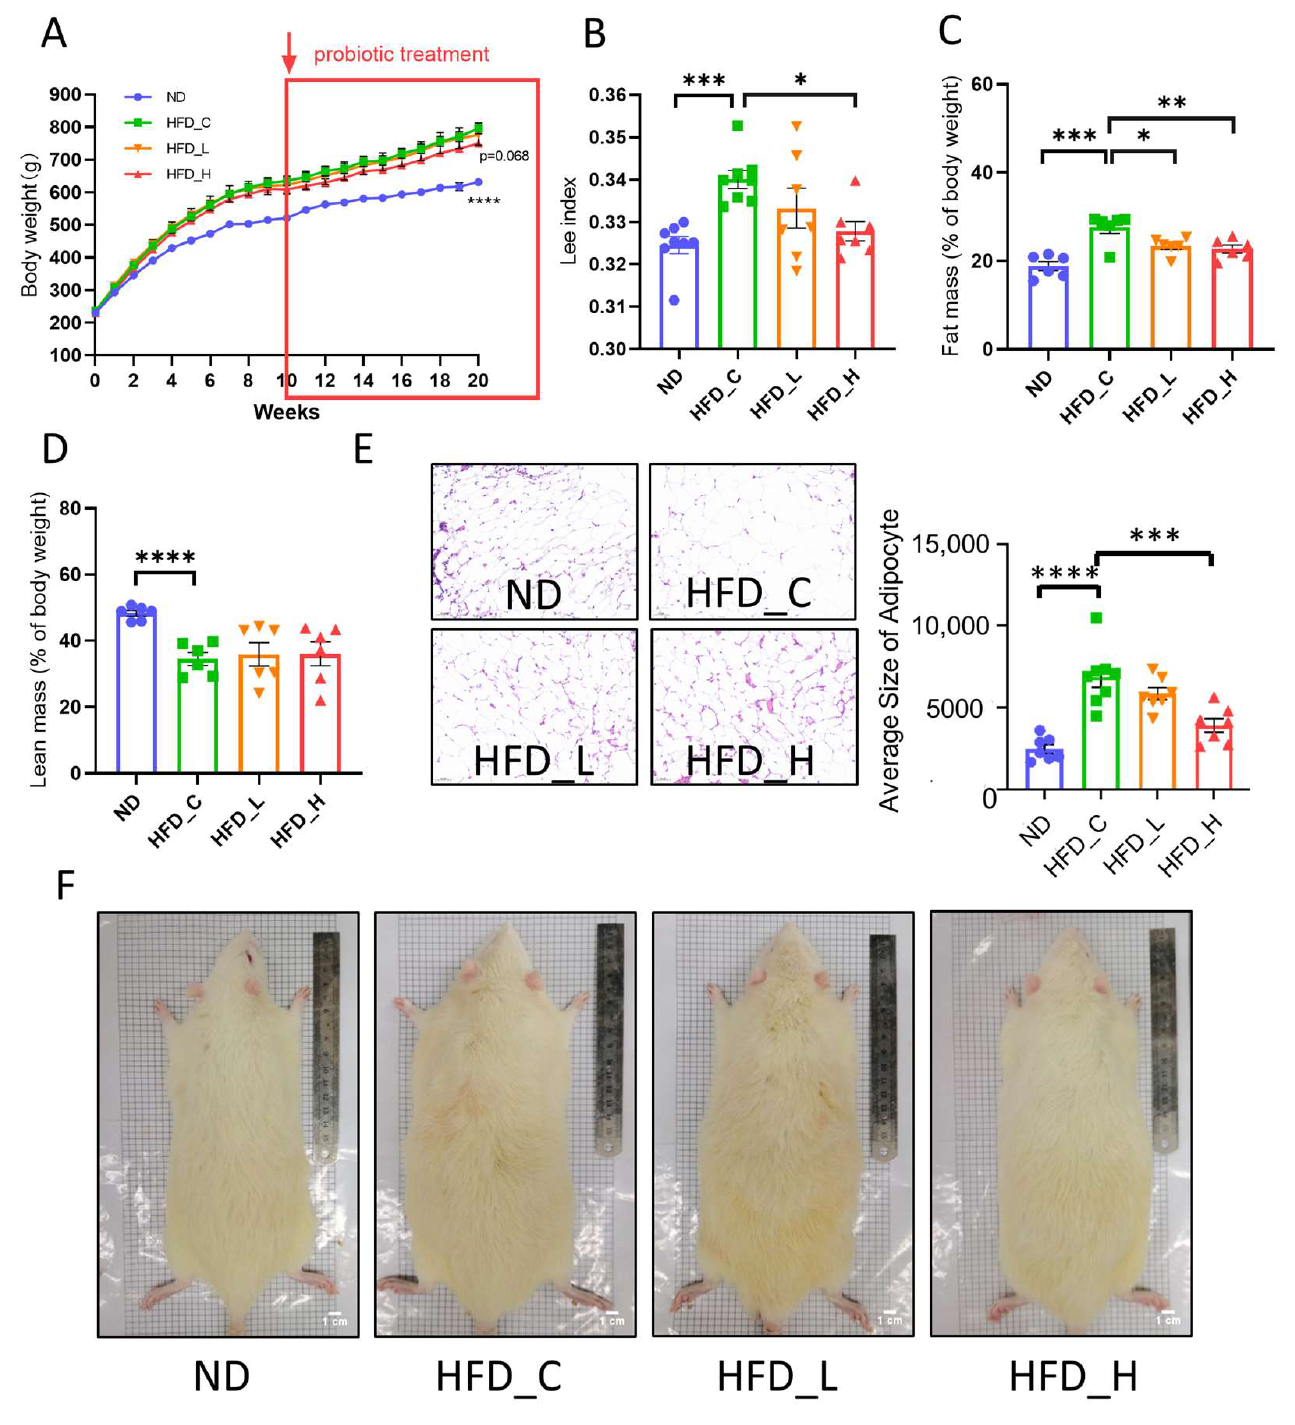
Figure 1. Effects of symbiotic supplementation on body weight and body fat in rats. Comparative measurements of ( A ) body weight, ( B ) Lee index, ( C ) fat mass and ( D ) lean mass in the four treatment groups. ( E ) Typical hematoxylin and eosin (H&E) staining of epididymal fat from rats and average epididymal adipocyte size in the four groups. ( F ) Representative photos of rats from each group. Data are presented as mean ± SEM; * p < 0.05, ** p < 0.01, *** p < 0.001 and **** p < 0.0001 compared with the HFD_C group. ND = normal diet group; HFD_C/L/H = high-fat-diet control/high-fat-diet + low-dose symbiotic/high-fat-diet + high-dose symbiotic groups.